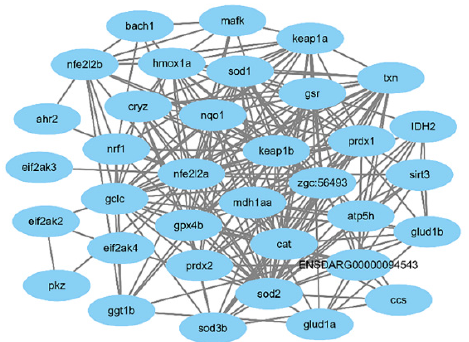
Figure 11. The protein–protein interactions of oxidative-related genes.